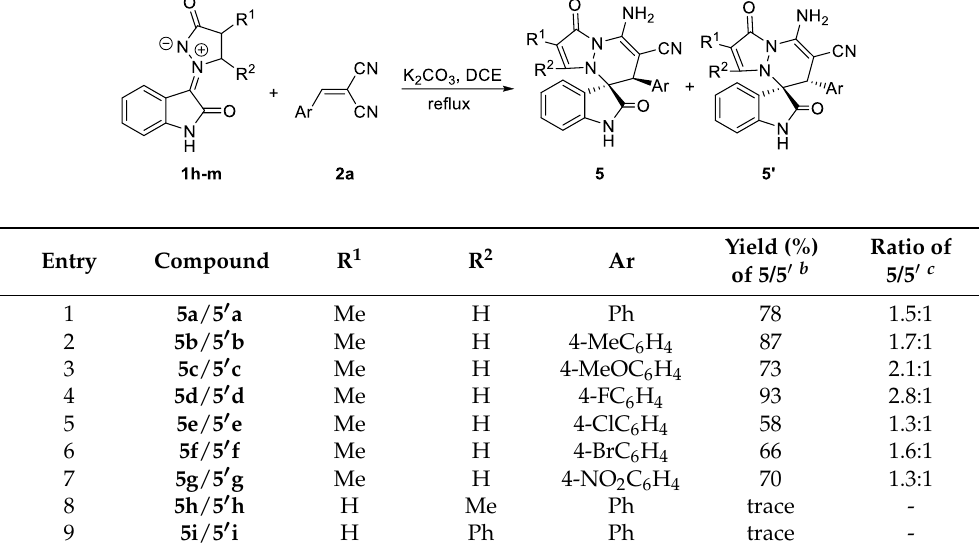
Figure 3. X-ray crystal structure of 4a (CCDC: 2151254).